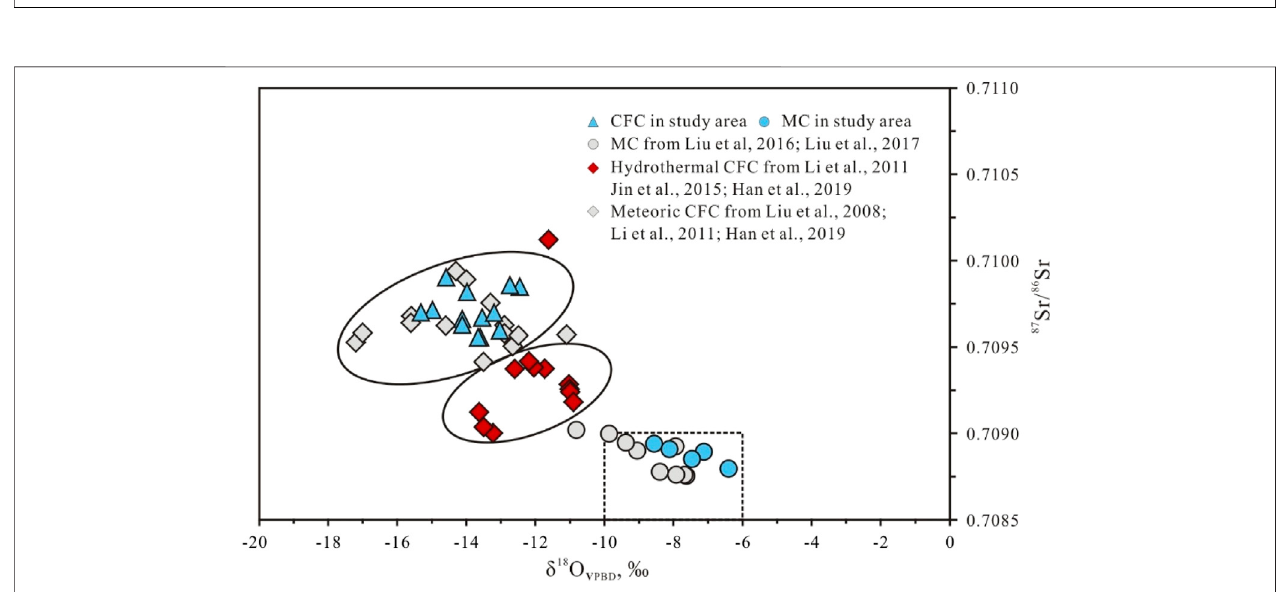
FIGURE 9 | A scatter diagram of δ 18 O values and 87 Sr/ 86 Sr ratios in the Yingshan Formation. The dashed box signi fi es the isotopic value range of marine calcites summarized by Veizer et al. (1999). The solid-line areas indicate the isotopic value ranges of various CFCs.